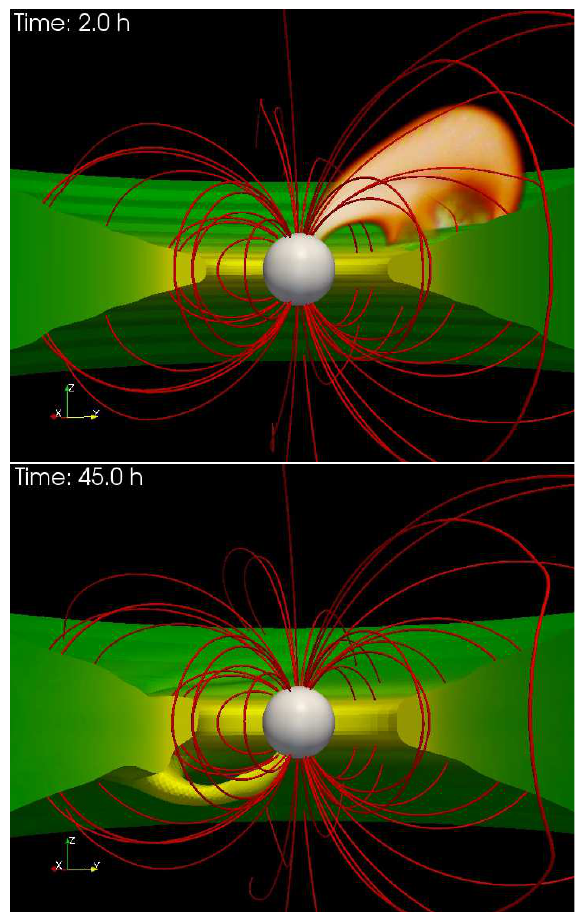
Figure 1: Effects of a single bright flare on the sta- bility of the circumstellar disk. Cutaway views of the star-disk system showing the mass density of the disk (yellow-green) at t = 2 . 0 hours (upper panel) and at t = 45 hours (lower panel) since the injection of the heat pulse. The upper panel also over-plots the three- dimensional volume rendering of the plasma tempera- ture (MK), showing the flaring loop (in red) linking the inner part of the disk with the star. The lower panel shows the accretion stream triggered by the flare in the side of the disk opposite to the flaring loop. Selected magnetic field lines are overplotted in